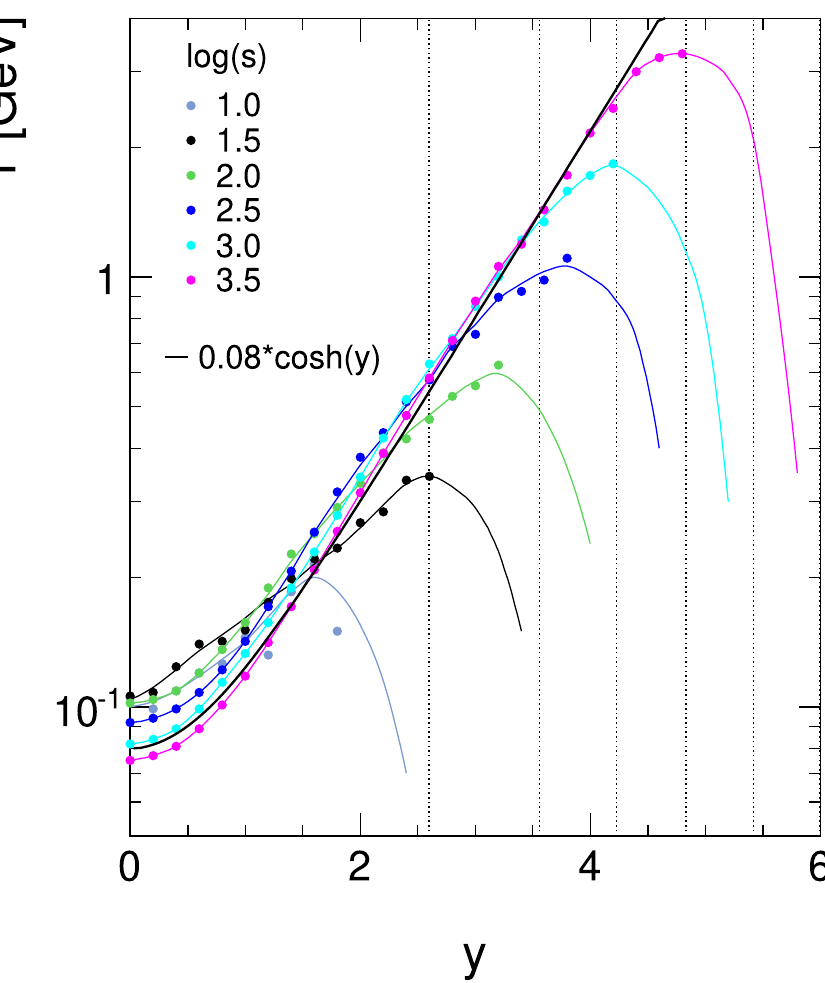
Fig. 144 Tsallis fit parameters T and q (53) for log ( s ) from 1 to 3.5 as a function of